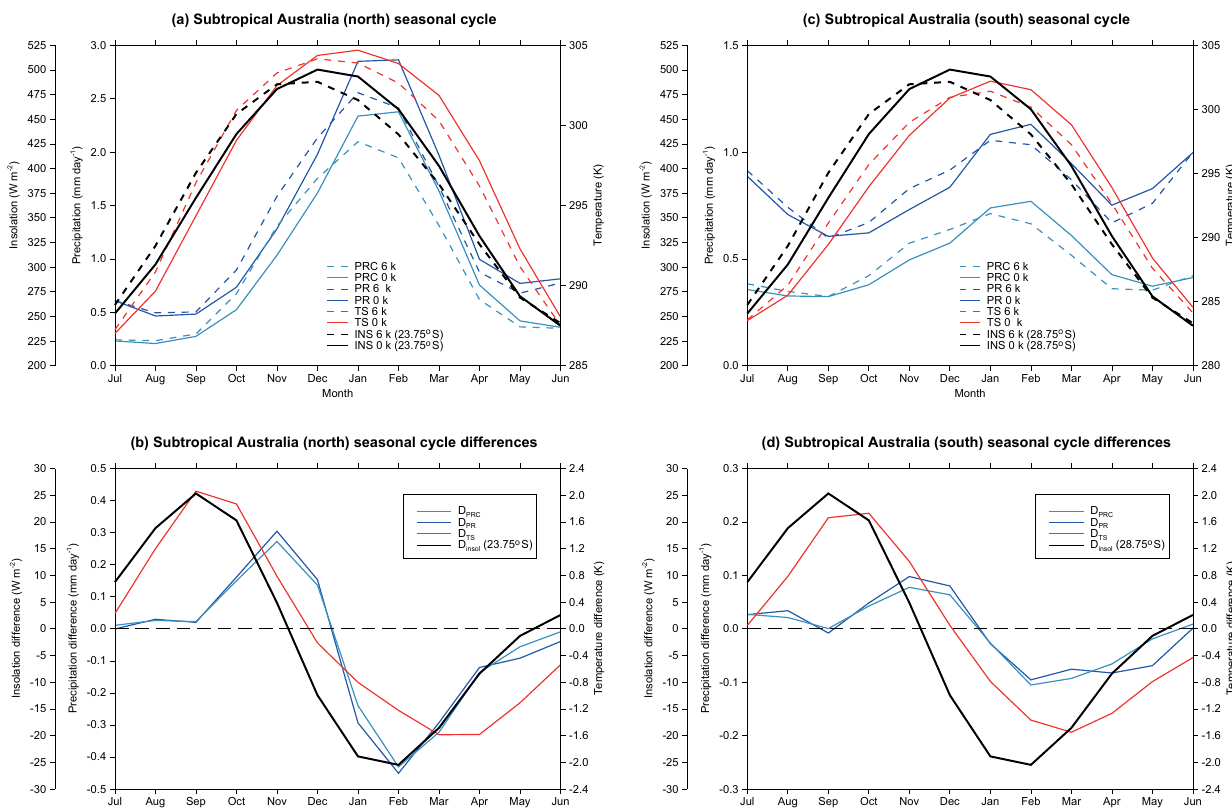
Figure 9. The monthly, ensemble and regional mean insolation (taken at 23.75 ◦ S for insolation, black line, Wm − 2 ), surface temperature (red line, K), total precipitation (blue line, mmday − 1 ) and convective precipitation (turquoise line, mmday − 1 ) at 0ka (solid lines) and 6ka (dashed lines) within (a) the northern half of the subtropical arid box and (b) the difference in those same fields for 6 − 0ka for the northern half of the subtropical arid zone. Equivalent figures for the southern half of the subtropical arid zone ( c and d , insolation at 28.75 ◦ S) are also